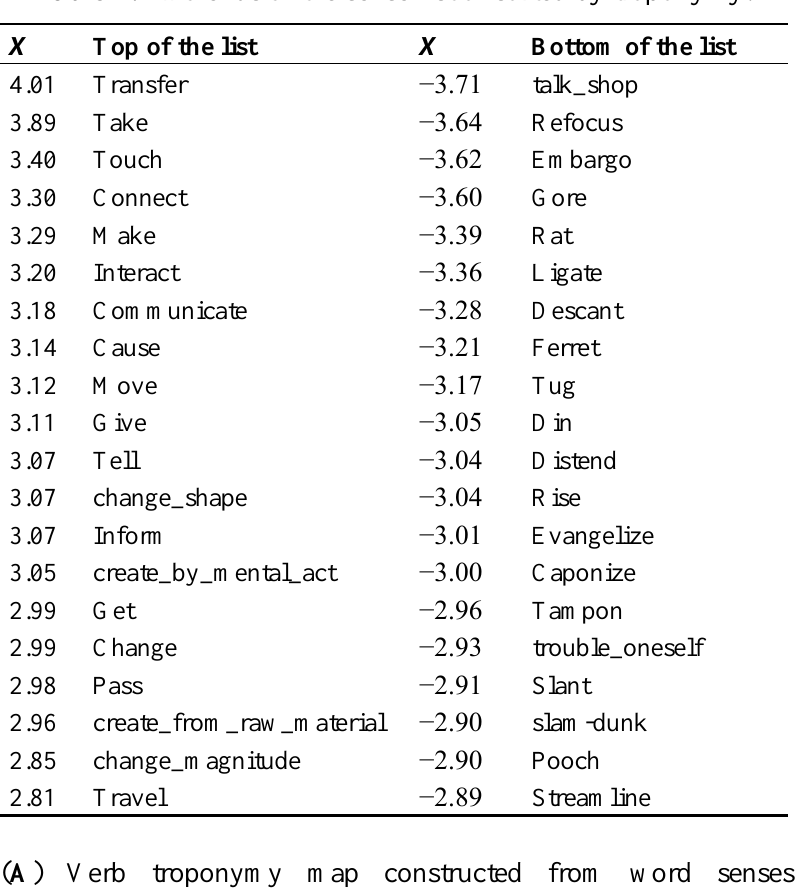
Table 7. Two ends of the sense list of sorted by troponymy.